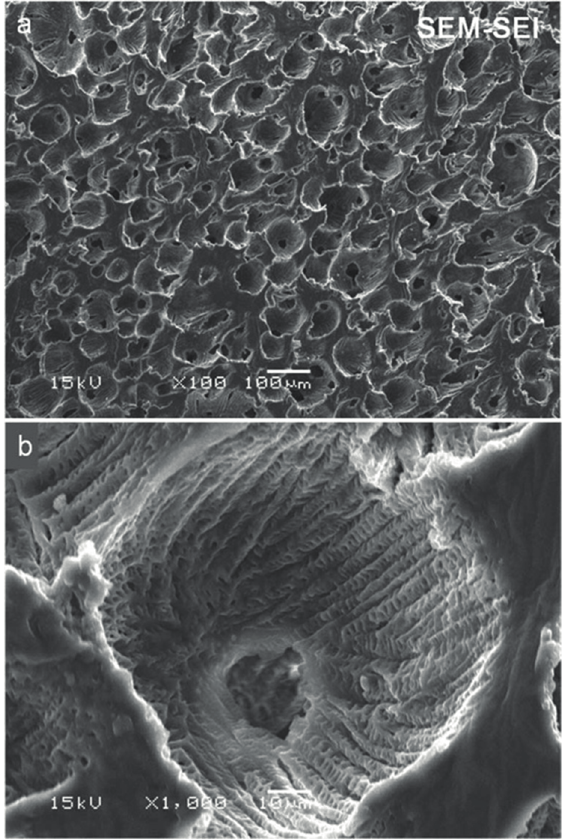
Figure 4 - SeI micrographs of the freeze-cast foamed poly(styrene-butyl acrylate-acrylic acid) latex show ( a ) pore distribution and ( b ) inter- connected pore details. Note the intricate structure of the pore walls in b). Reproduced (adapted) from (Da Silva and Galembeck 2015) with permission from The Royal Society of